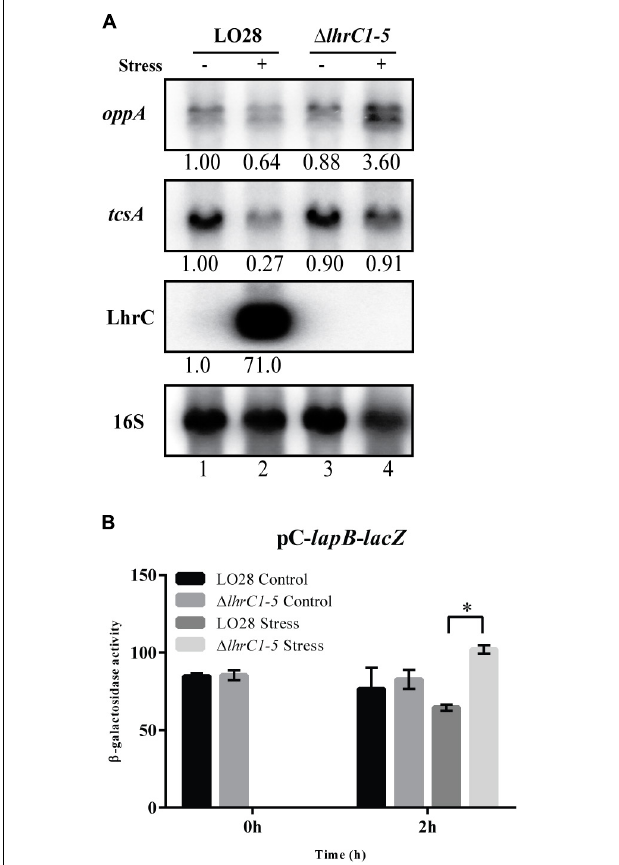
FIGURE 3 | LhrC-mediated down-regulation of the known target genes oppA , tcsA and lapB . (A) Northern blot analysis of oppA mRNA, tcsA mRNA and LhrC1–5. Samples were taken from LO28 wild-type and (cid:49) lhrC1–5 cultures exposed to 8 µ M hemin stress for 1 h (+) as well as from non-stressed cultures (–). Northern blots were probed for oppA mRNA, tcsA mRNA, LhrC1–5 and 16S rRNA (loading control). Relative levels of oppA mRNA, tcsA mRNA and LhrC1–5 (normalized to 16S) are shown below each lane. (B) β -galactosidase assay of LO28 wild-type and (cid:49) lhrC1–5 strains carrying a translational reporter gene fusion of lapB to lacZ in the vector pCK-lac (Sievers et al., 2014). β -galactosidase activities of wild-type and mutant cells were measured at the indicated time points under non-stress conditions (Control) and after exposure to 8 µ M hemin (Stress). The results are the average of three biological replicates, each carried out in technical duplicates. After 2 h of stress, a significant difference (asterisk) between the mutant and wild-type cells was observed ( p <